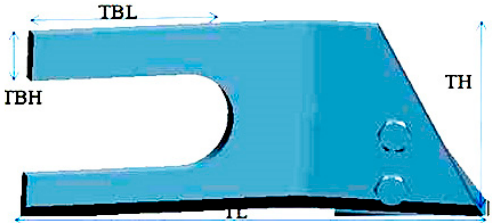
Figure 6. Schematic views of 3D solid model of a trash-boar. TL: trash length; TBL: trash blade length; TBH: trash blade height; and TH: trash